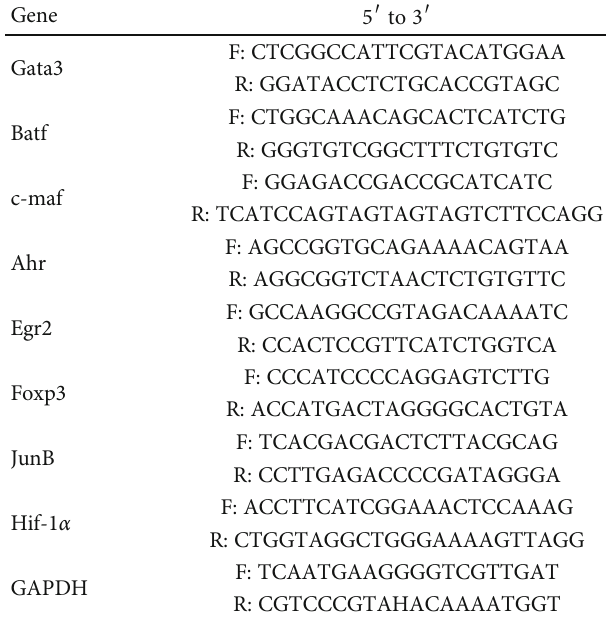
Table 2: Sequence of primers used for